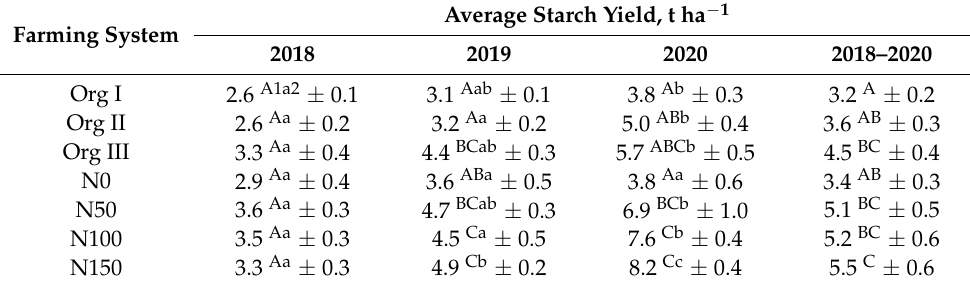
Table 7. Average starch yield depending on the farming system. Farming System